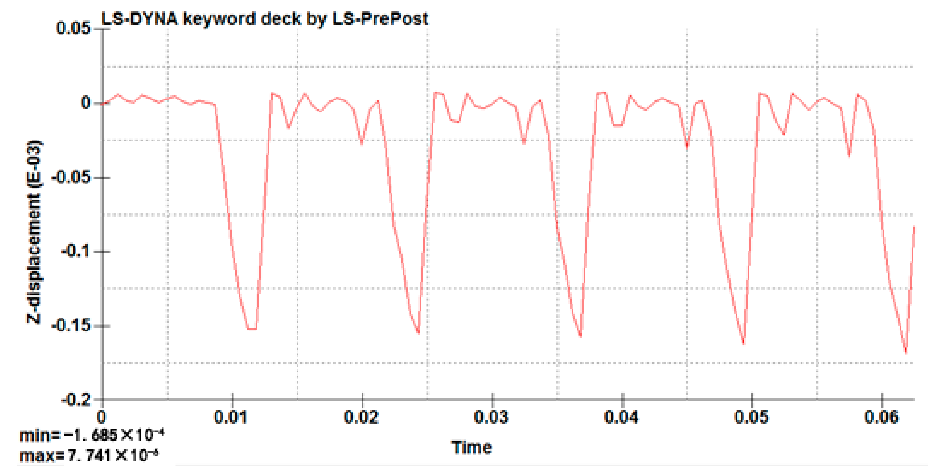
Figure 14. Displacement at the mid-point of weld.